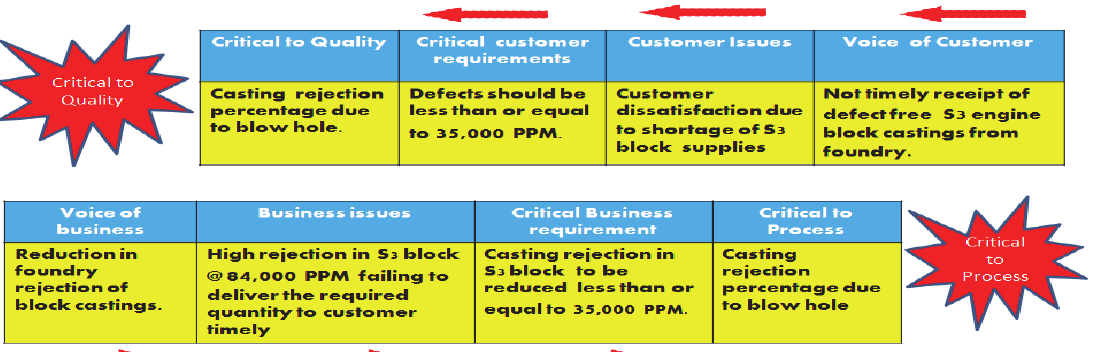
Fig. 2. Critical To Quality / Critical to Process